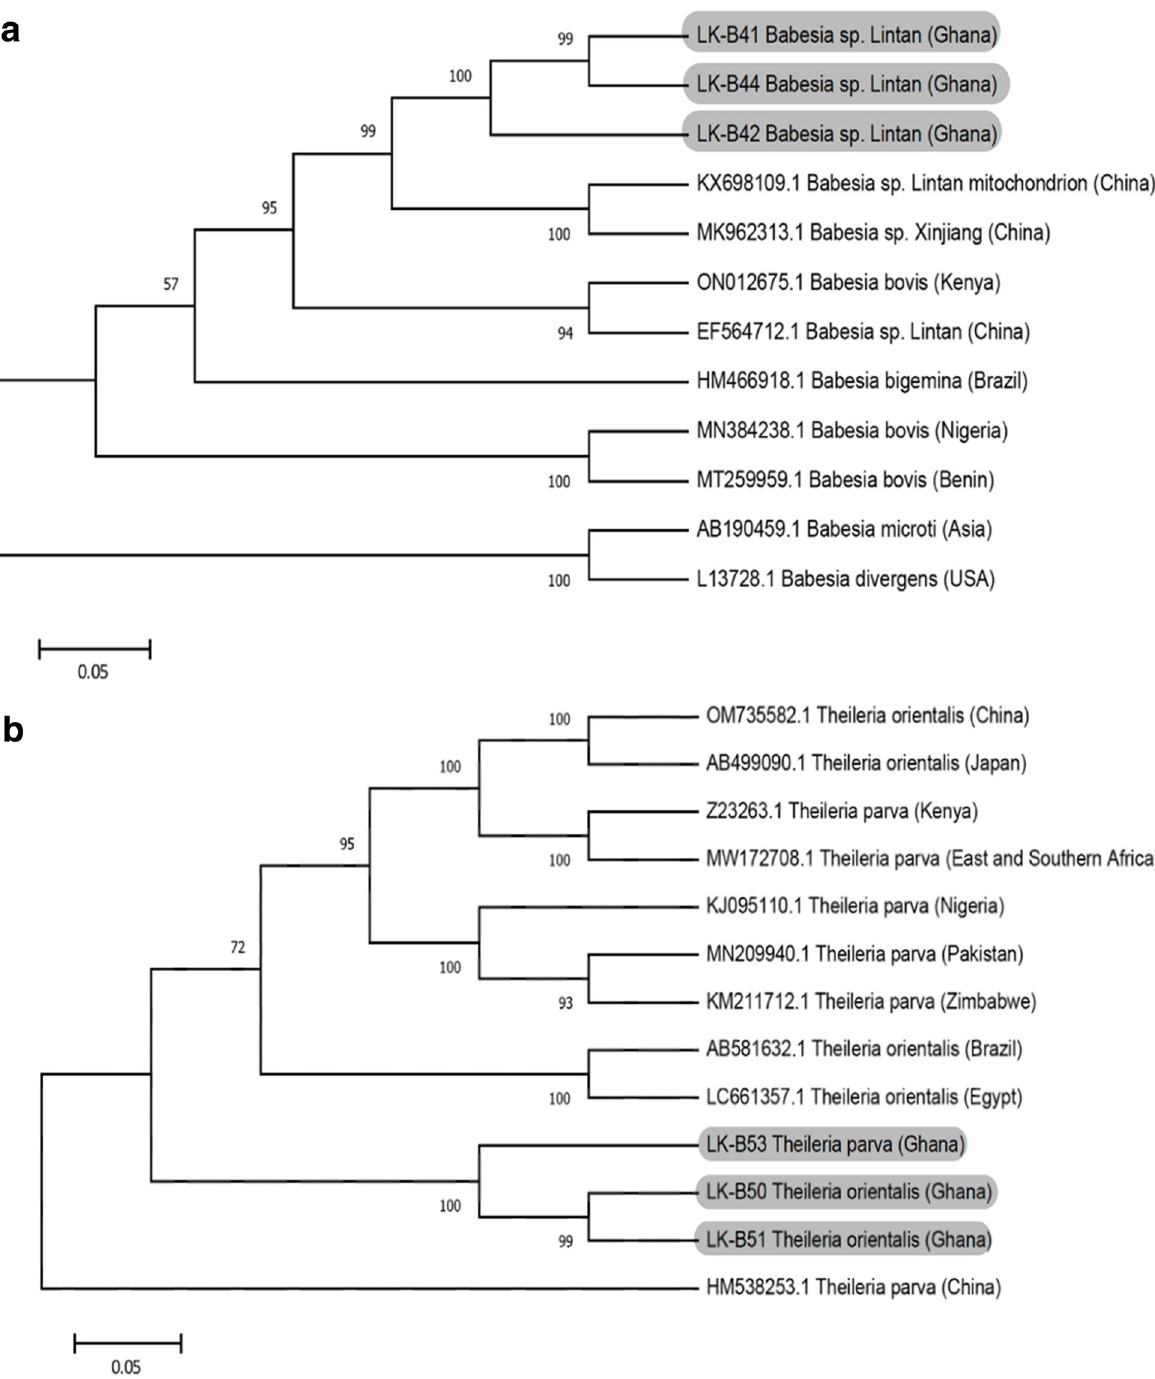
Fig. 1 Phylogenetic analysis of Babesia and Theileria in the livestock based on the rRNA gene fragments (lsu5‑lsu4) of mitochondrial genome. a Babesia . The sequences obtained in this study are indicated as LK‑B41, LK‑B42 and LK‑B44. b Theileria . The sequences obtained in this study are indicated as LK‑B50, LK‑B51 and